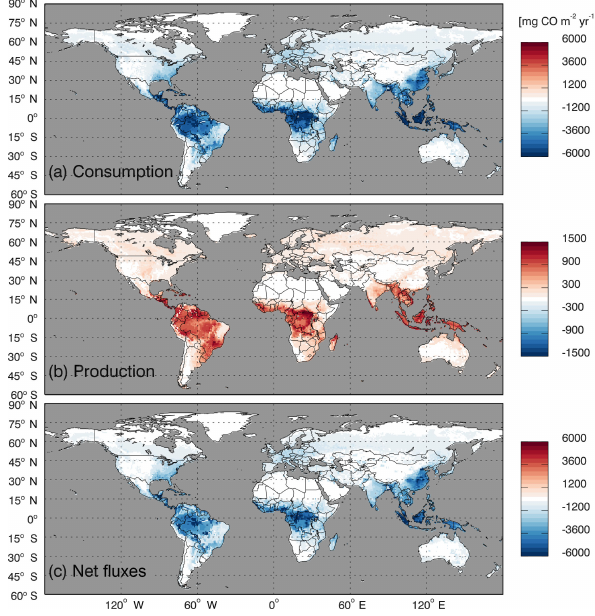
Figure 8. Global annual mean soil CO fluxes (mg CO m − 2 yr − 1 ) during 2000–2013 using the MOPITT CO atmospheric surface con- centration